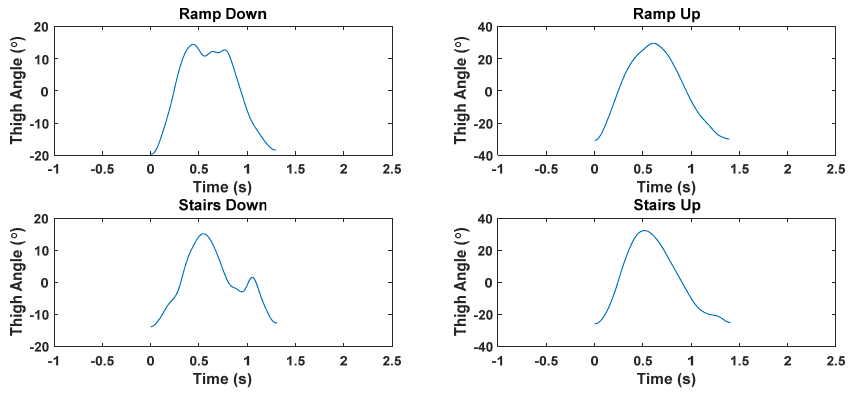
Figure 19. Thigh angle patterns for different activities.